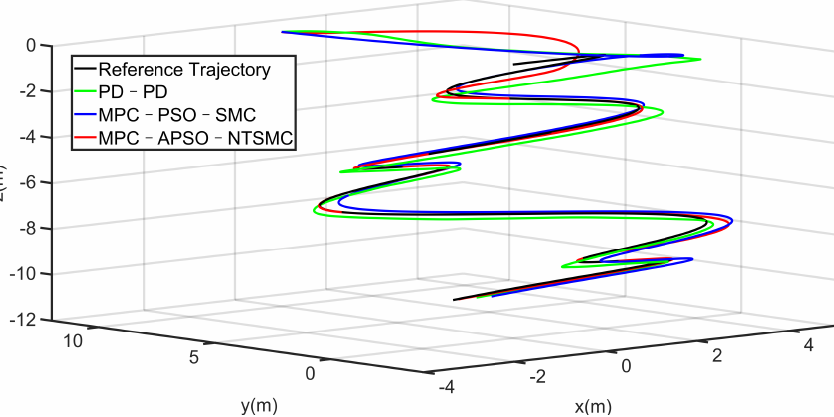
Figure 21. AUV complex curve trajectory tracking without disturbance for Case 2.